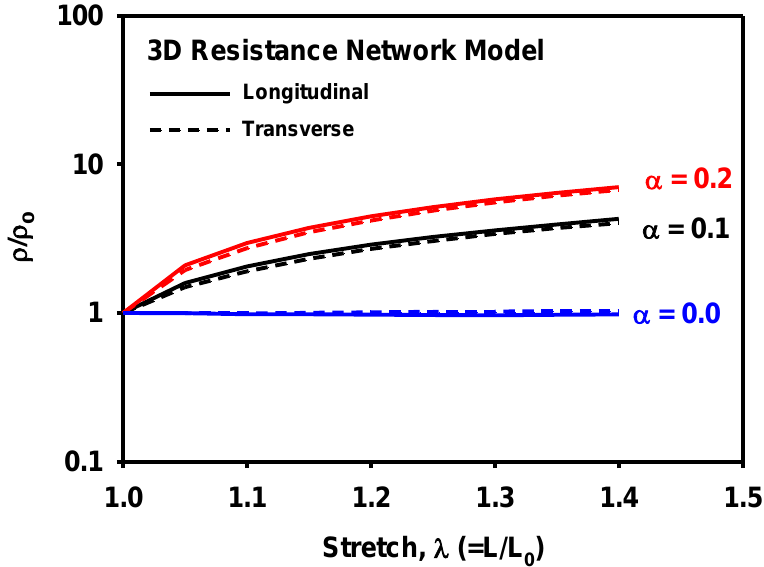
Figure 17. Variation of normalized resistivity with various values of α as calculated by the 3D resistance network model.